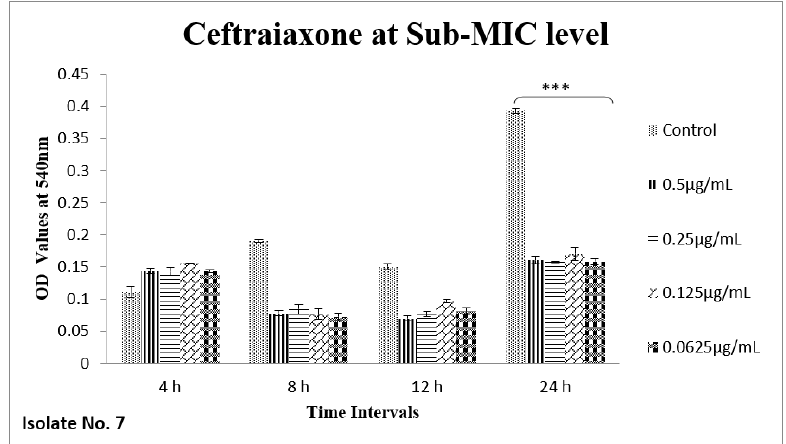
Figure 3. Shown are the effects of ceftriaxone on biofilm formation of E. coli at different time intervals (OD 540 nm). Bar graph represents significant reduction (*** p value < 0.001) of biofilm formation at different time points compared to the control samples.